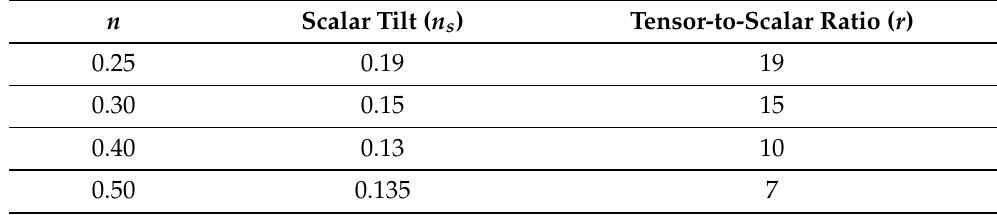
Table 4. Values of n s and r with the parameter n for t s =